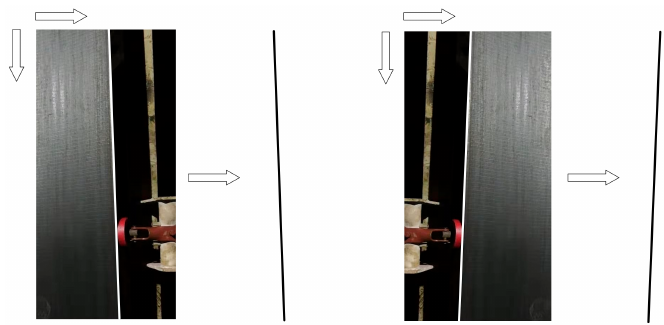
Figure 10. Image scanning direction and line segment